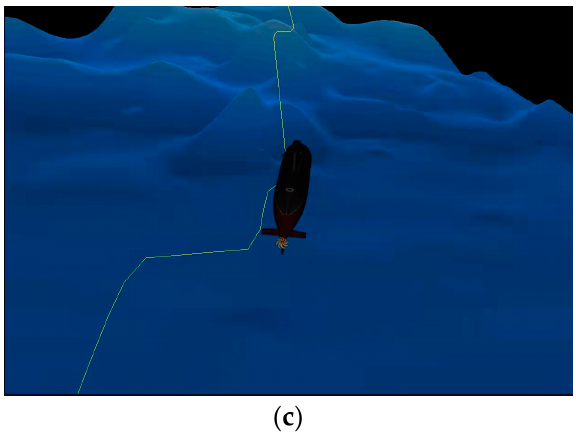
Figure 17. System experimental results, where ( a ) is the overview of the global path, ( b ) is the submarine depth curve, and ( c ) is the path planning from the third person view.